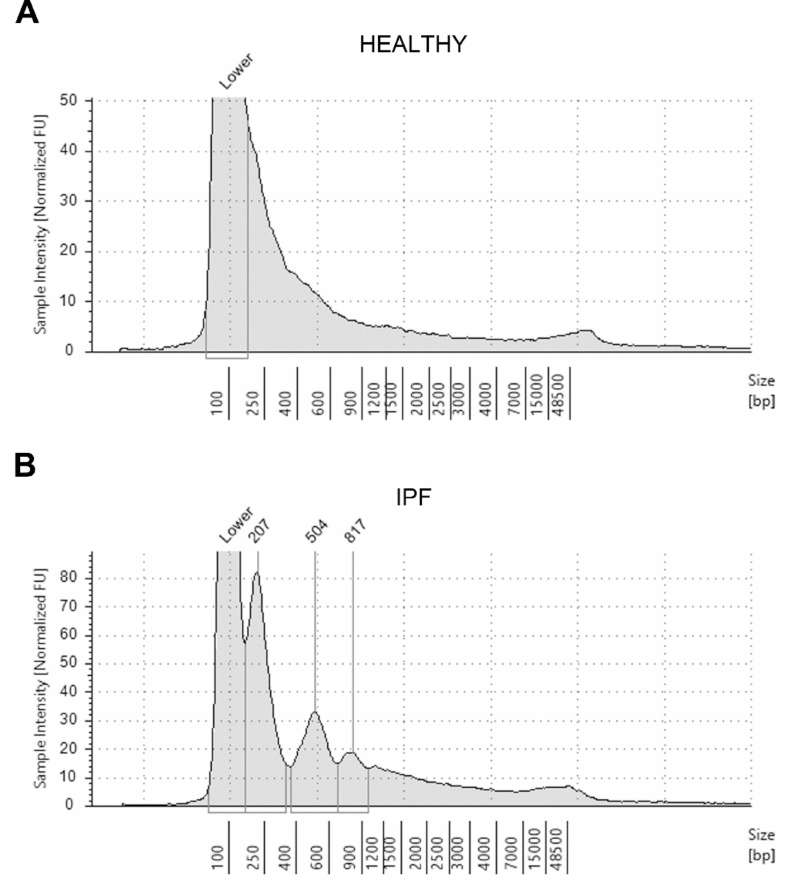
Figure 2. Representative electrophoretic run and distribution pattern of circulating cell-free DNA extracted from the plasma sample of an healthy individual ( A ) and a patient affected by idiopathic pulmonary fibrosis (IPF) ( B ), as analyzed with the Tape Station 2200 system (see Methods